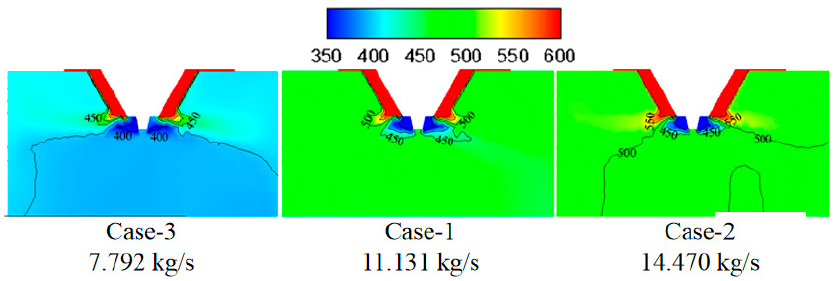
Figure 5. Temperature under different flue gas flow rates (K).